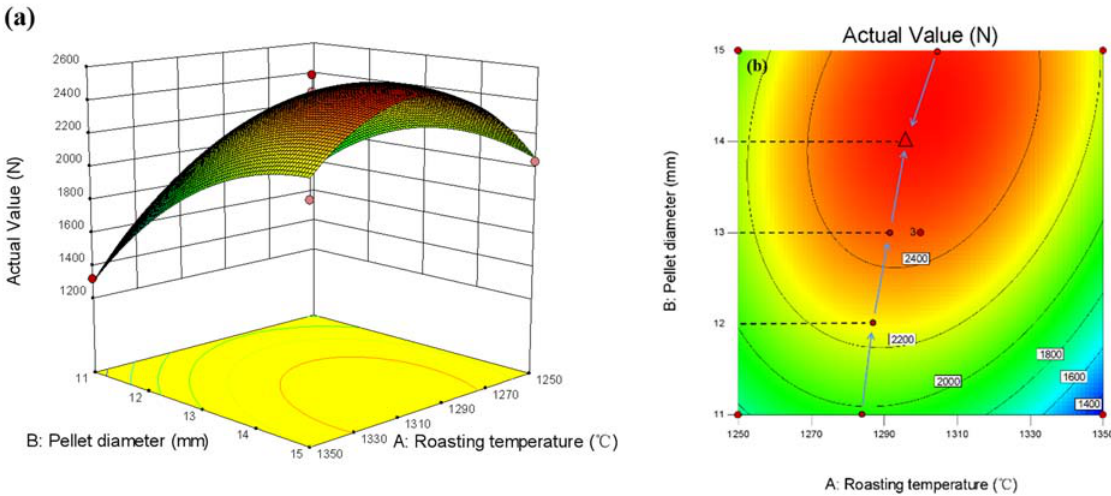
Figure 19. Response surface plot between pellet diameter, roasting temperature, and pellet com ‐ pressive strength: ( a ) 3D response surface plot, ( b ) optimal parameter contour plot.